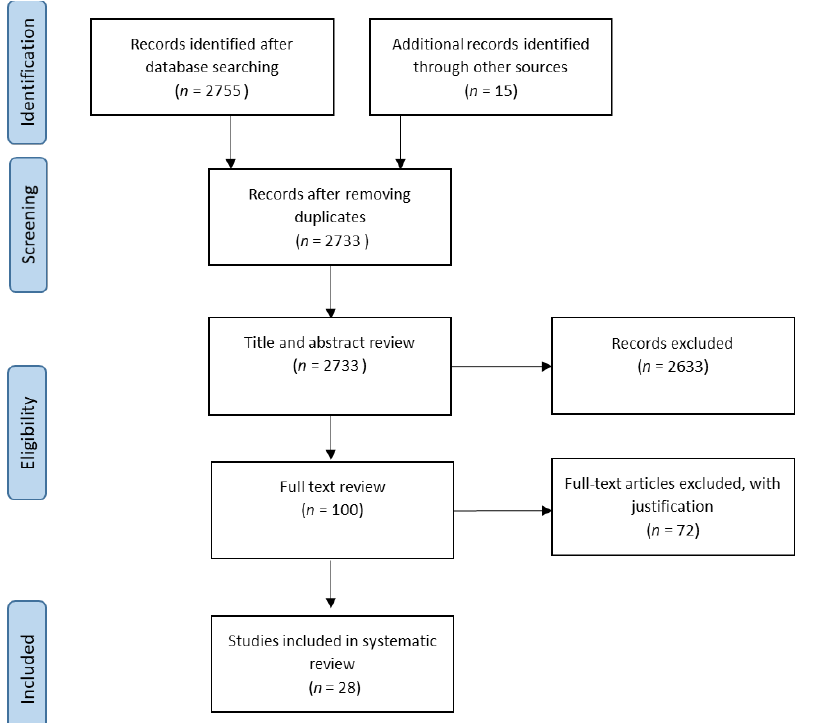
Figure 1. PRISMA flowchart that displays the number of records identified (2733), the number of records screened for a full-text review (100), and the number of records included in the review (28).